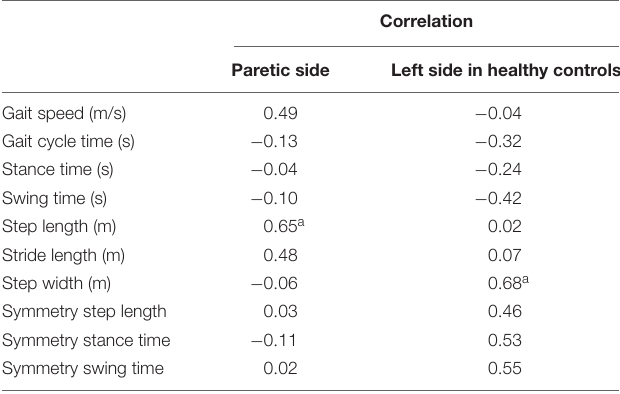
TABLE 5 | The correlations between walking activity and surface difference in spatiotemporal